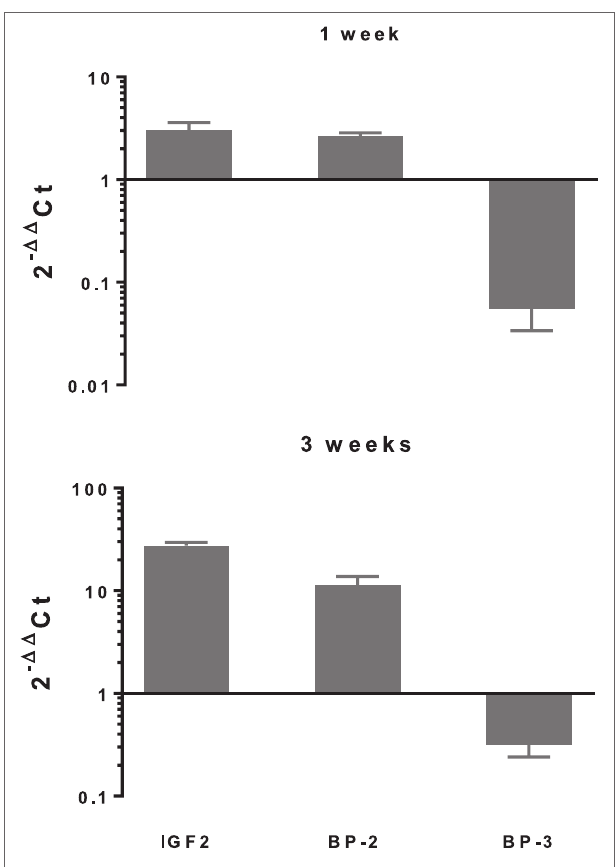
FigUre 1 | Changes in expression of selected insulin-like growth factor (IGF) axis genes in cDPCs cultured under osteogenic conditions. Relative changes in selected IGF axis gene expression in cDPC cultured in monolayers under osteogenic conditions for 1 and 3 weeks are indicated. Cultures were derived from three donors and triplicate technical replicates were performed for each donor. Data are presented as mean ± SD ( n = 3). The relative gene expression was normalized to corresponding controls cultured under basal conditions and is expressed as 2 −ΔΔ Ct